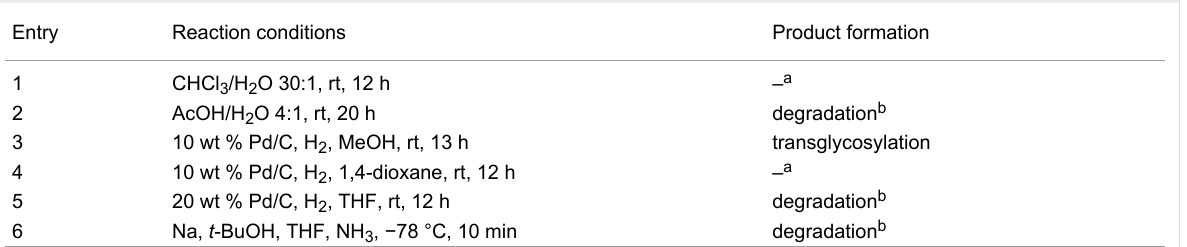
Table 1: Tested reaction conditions for the deprotection of benzylidene derivative 6